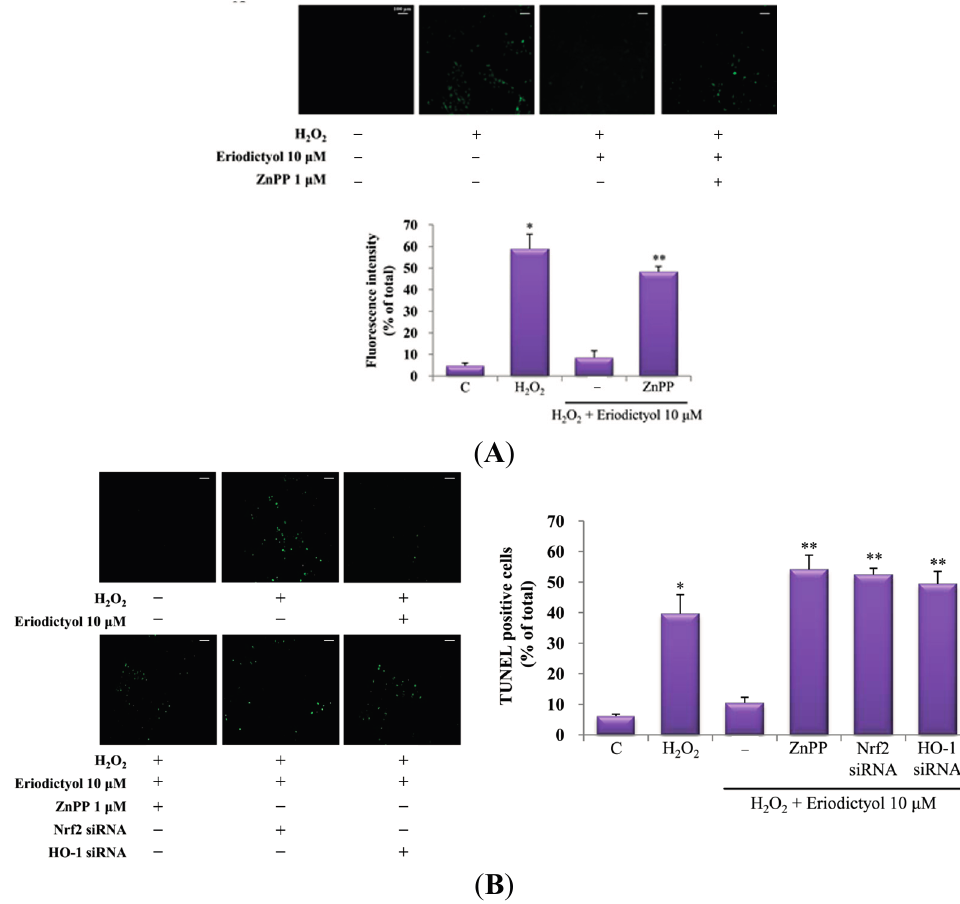
Figure 7. Protective effect of eriodictyol-induced HO-1 expression on H 2 O 2 -induced